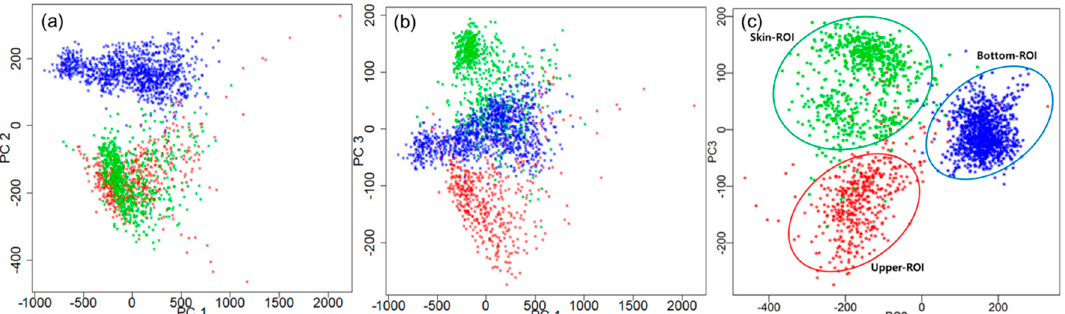
Figure 5. Score plot of three groups with PC2 and PC3 space in 2 dimensional. Red asterisks denote upper-ROI, blue ones are bottom-ROI, and green ones are